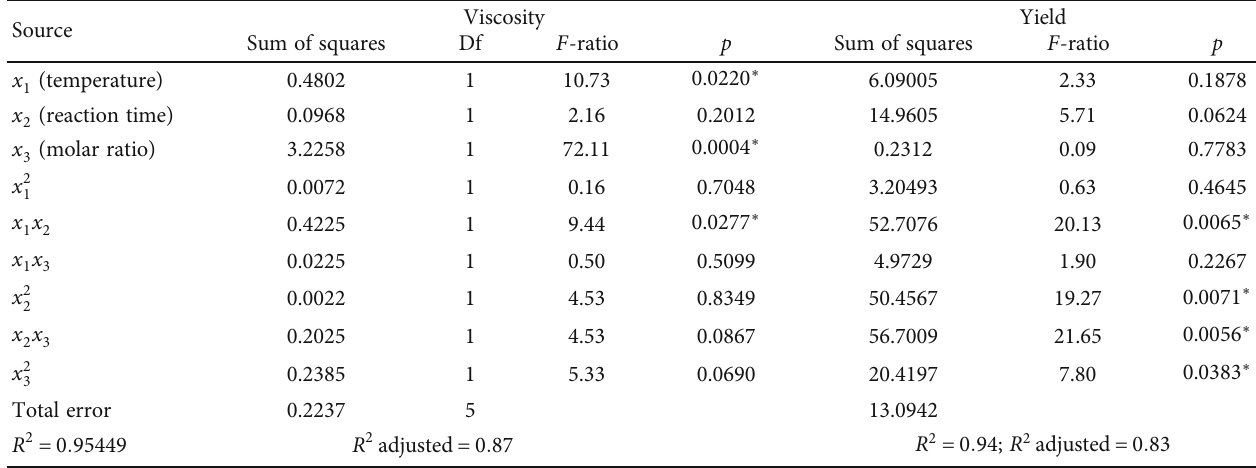
Table 4: ANOVA results for biodiesel yield and